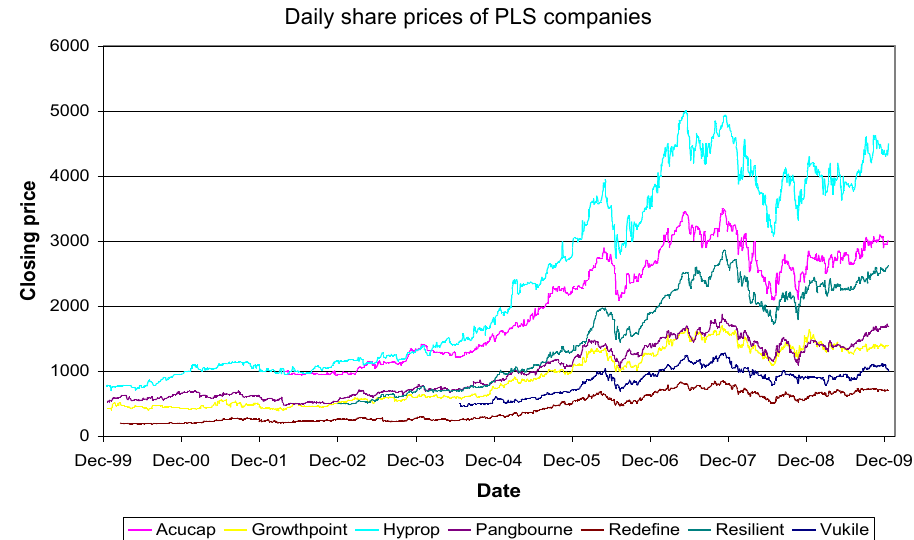
Daily share prices of PLS